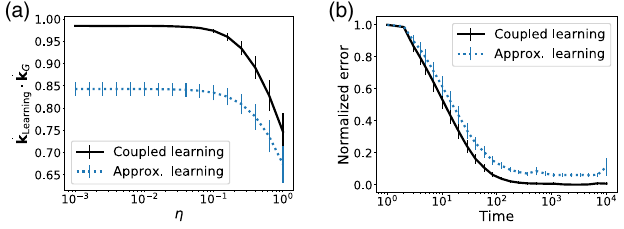
FIG. 5. Training a flow network (512 nodes, 10 random sources, and 3 random targets) with an approximate, experimen- tally viable learning rule. (a) The full coupled learning rule [Eq. (4)] and the approximate learning rule [Eq. (8)] are compared to the gradient of the cost function for different values of η [see Fig. 7(c)]. While the full learning rule is superior, there is still a significant correlation between optimal tuning and the approxi- mate rule. (b) The network may be trained using both the full and approximate rule, at similar timescales. The approximate learning rule, being much more restricted, often saturates at a higher error level compared to the full rule (averaged over 17 random source- target